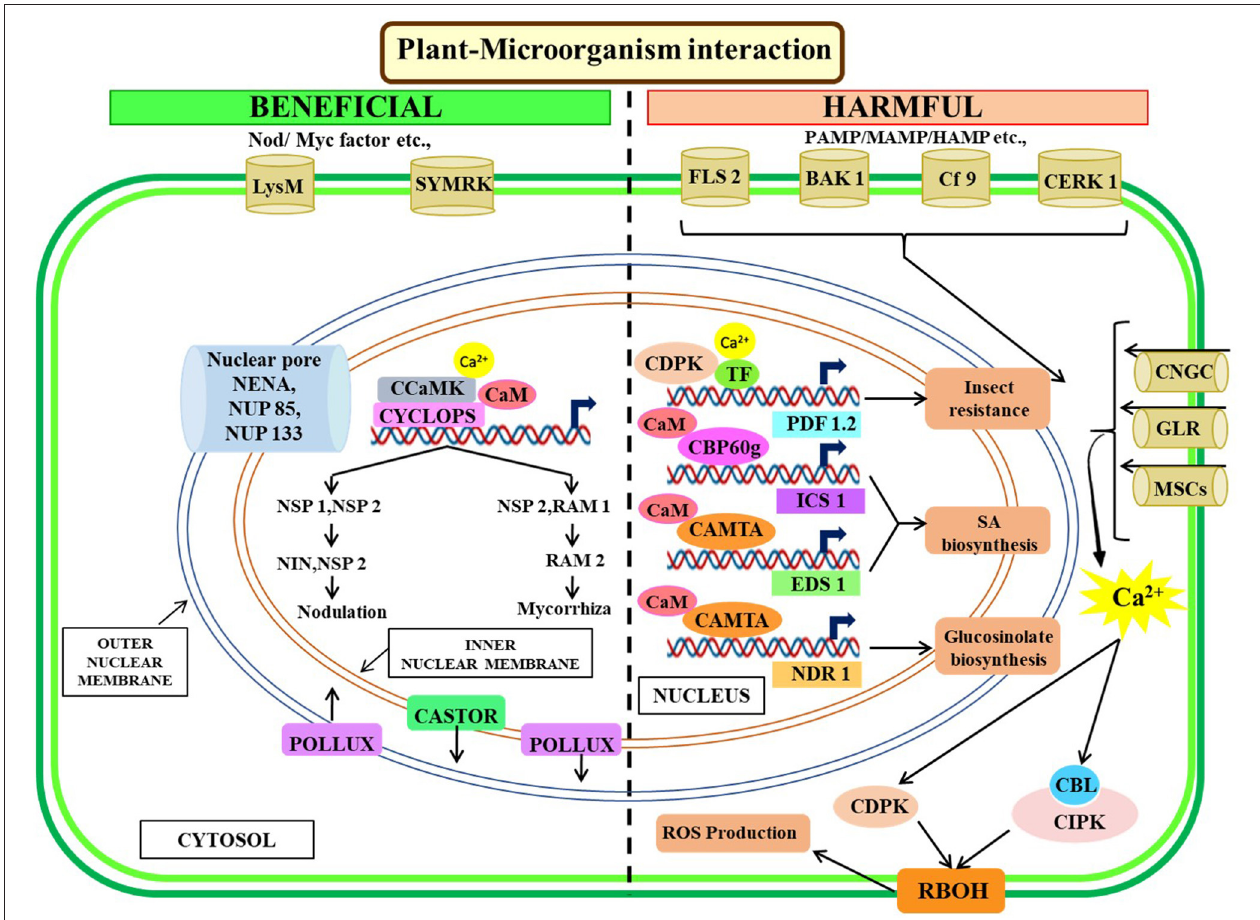
FIGURE 4 | Illustrative representation of crosstalk among Ca 2 + signaling components for plant’s biotic interactions. Symbiosis signaling starts with the perception of Nod/Myc factors and subsequent Ca 2 + signaling mediated activation of either nodulation through the expression of NIN, NSP1, NSP2, or mycorrhiza through RAM1, RAM2 expression. Nuclear membrane localized calcium channels (POLLUX, CASTOR) and nuclear pore complex are essential for plant-microorganism symbiosis. PAMP/MAMP/HAMP activates resistance pathways agents, biotic agents, through SA, glucosinolate biosynthesis, and ROS production during pathogenesis. The membrane-localized transporters trigger Ca 2 + in the cytoplasm upon interaction with harmful biotic agents which eventually triggers the CBL-CIPK-CAMTA-mediated signaling cascade for downstream gene expression. NDR, non-race-specific disease resistance1; MSC, mechanosensitive ion channels; SYMRK, symbiosis receptor-like kinase; FLS2, flagellin sensing 2; CERK1, chitin elicitor receptor kinase 1; CAMTA, calmodulin-binding transcription activators; CIPK, CBL-interacting protein kinases; CBLs, calcineurin B-like proteins.